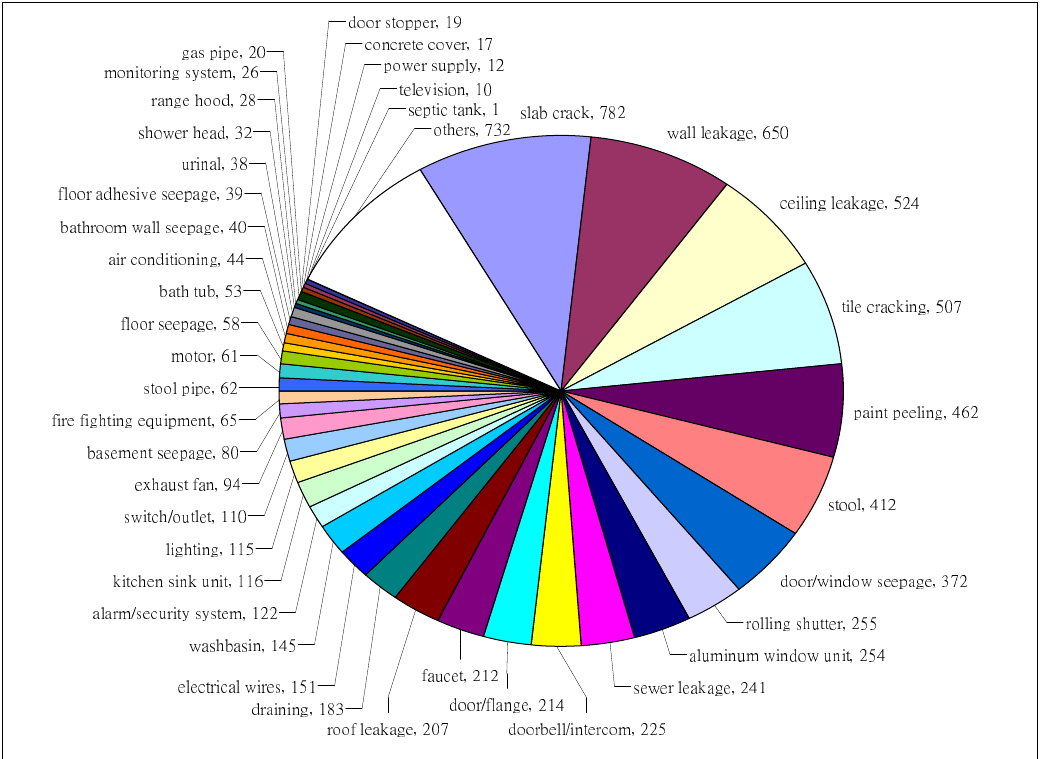
Fig. 1. Pie chart of maintenance works requested during